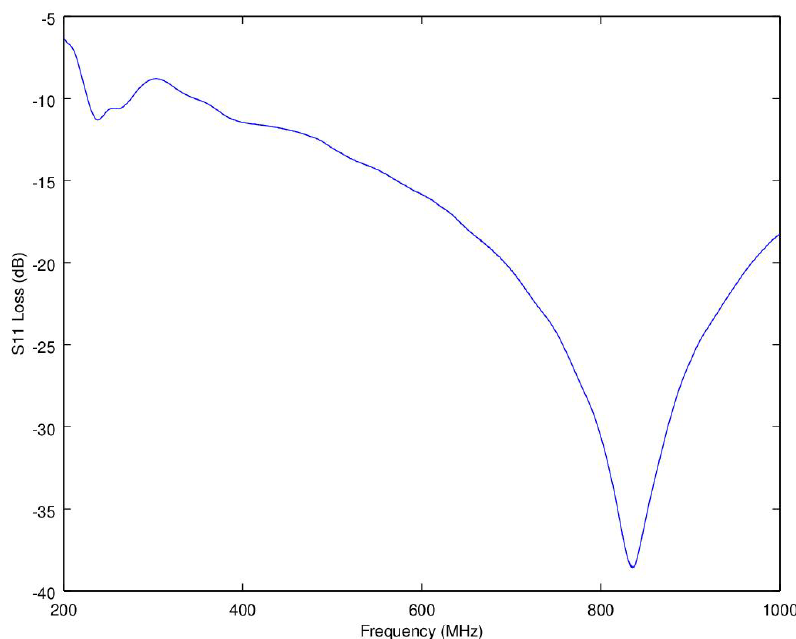
Figure 4. The new experimental probe’s network analyzer S11 response plot for ethylene glycol showing a high-quality impedance match above 350 MHz, with subsequent low reflection from the coax to probe structure (signal strength below − 10 dB).